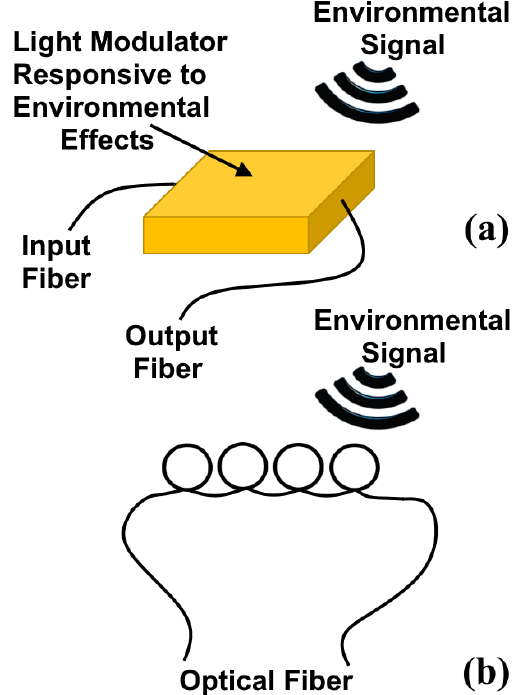
Figure 7. Schematic comparison between ( a ) extrinsic and ( b ) intrinsic sensors